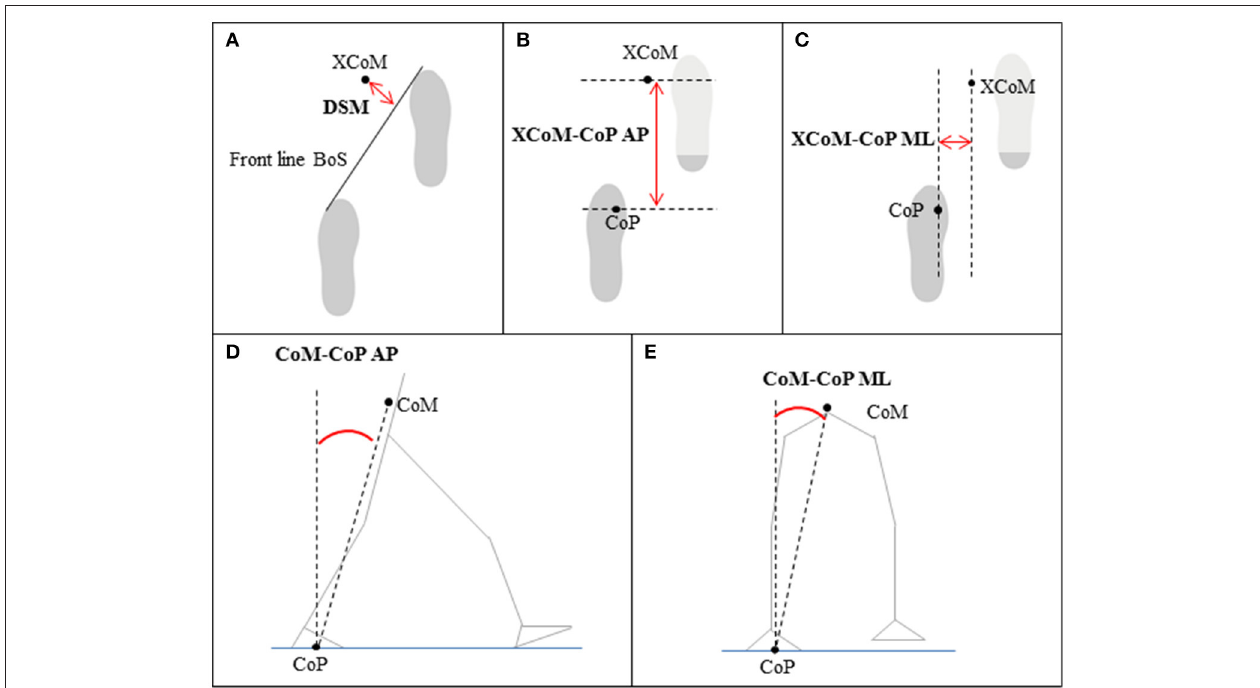
FIGURE 4 | Gait stability measures based on the position of the center of mass (CoM), extrapolated center of mass (XCoM), center of pressure (CoP), and/or base of support (BoS) relative to each other; (A) dynamic stability margin (DSM), (B,C) XCoM-CoP distance in anterior-posterior (AP) and medial-lateral (ML) direction, (D,E) CoM-CoP inclination angles in AP and ML